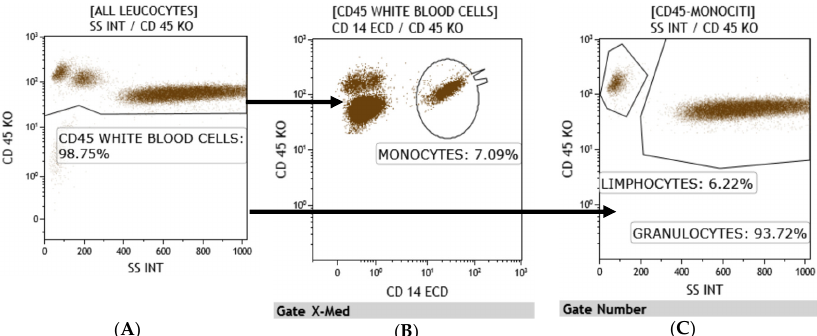
and were removed from the analysis.